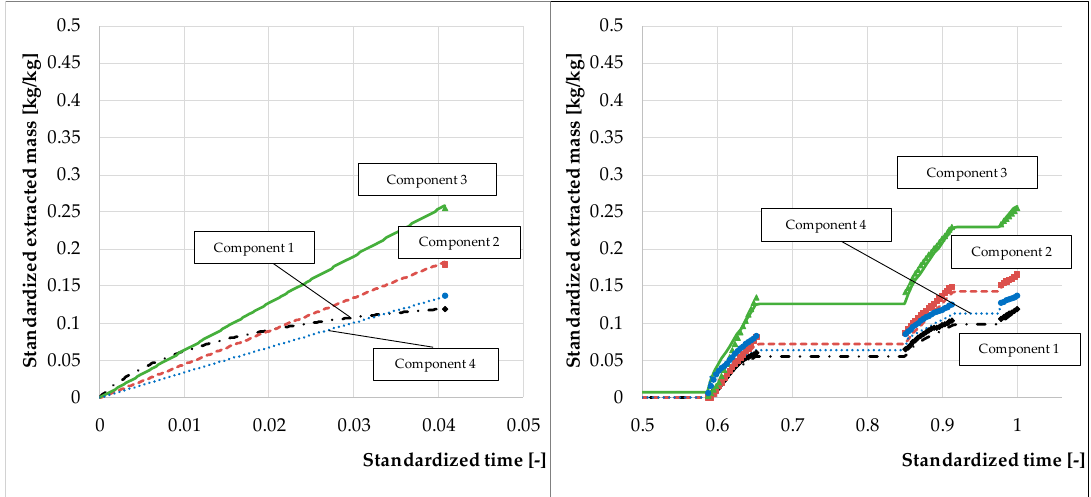
Figure 18. Comparison of the reference process (right) and a maceration (left) with constant product quality. Table 3. Overview of particle sizes in the reference process and the